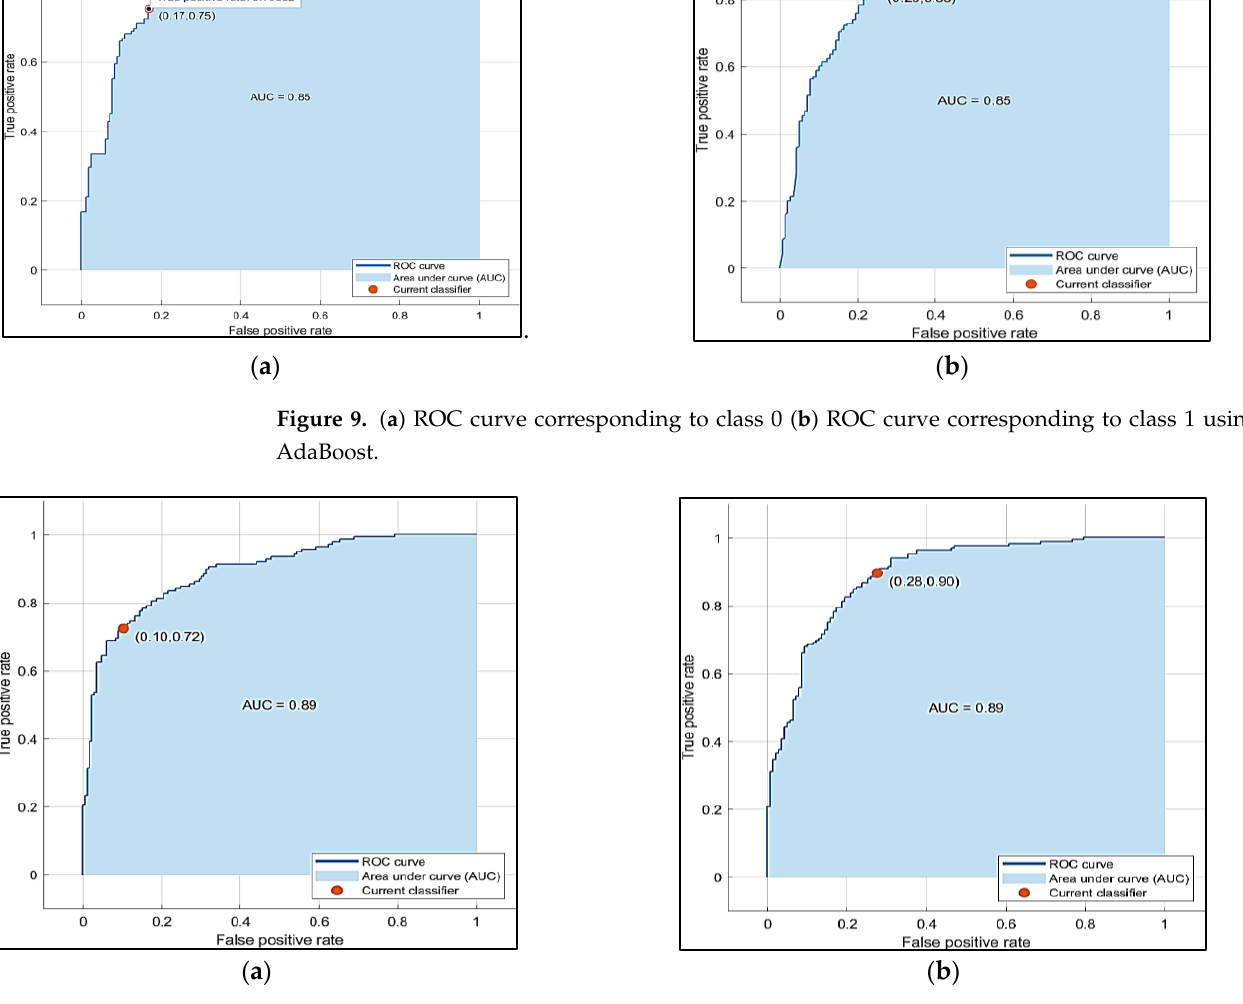
Figure 10. ( a ) ROC curve corresponding to class 0 using the SVM ( b ) ROC curve corresponding to class 1 using the SVM.